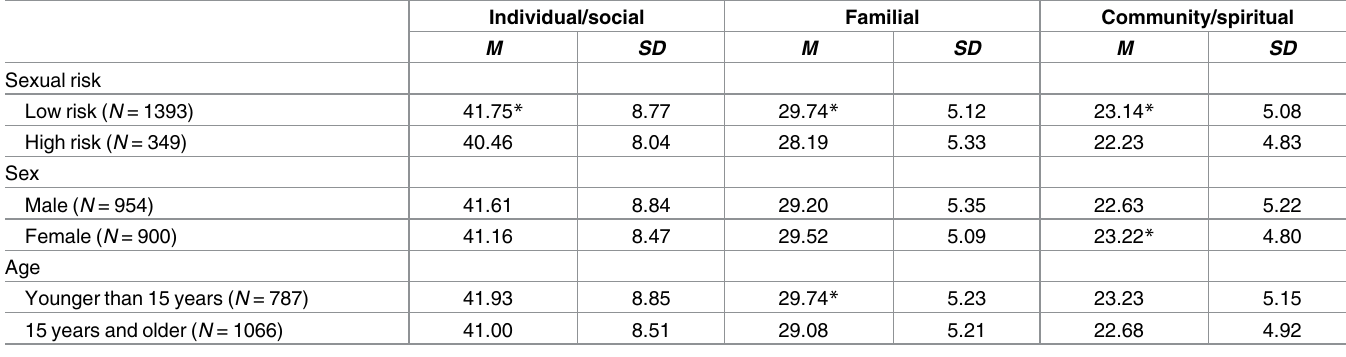
Table 5. Descriptivestatistics for CYRM-24 subscales by sexual risk, sex, and age